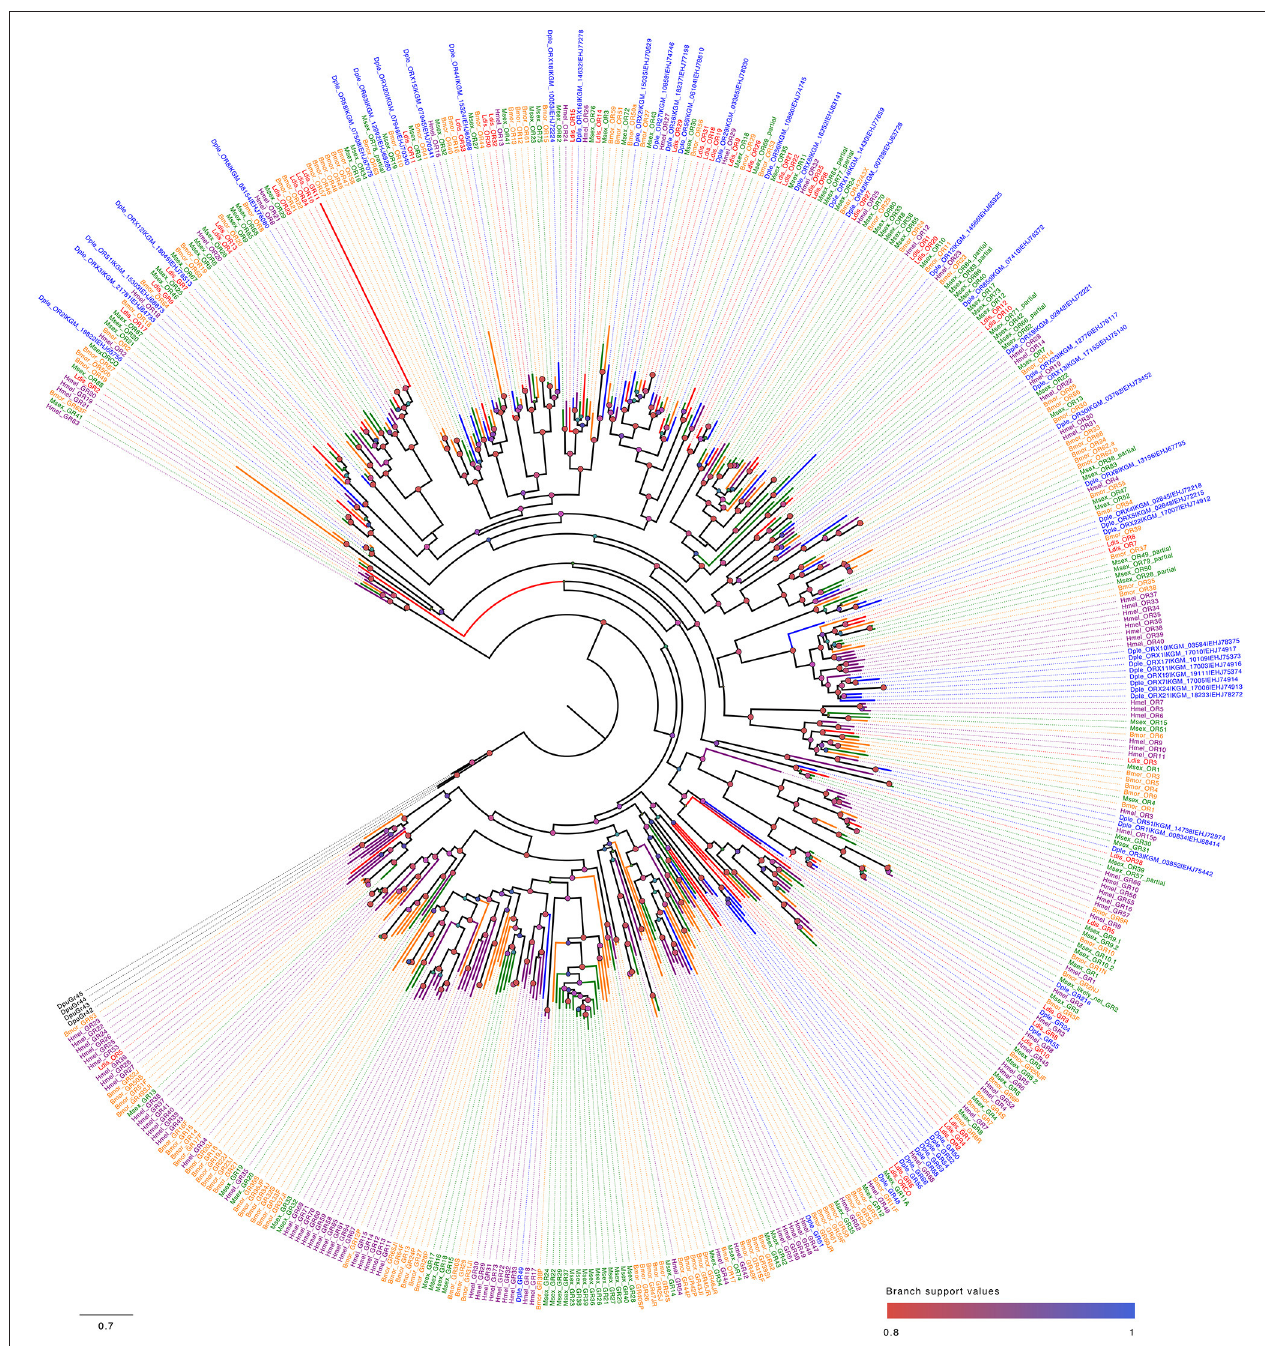
FIGURE 5 | Maximum likelihood dendrogram based on protein sequences of candidate gustatory receptors ( GRs ) and odorant receptors ( ORs ). Included are the putative sequences for Lymantria dispar (Ldis) plus those available for model Lepidoptera species Bombyx mori (Bmor), Danaus plexippus (Dple), Heliconius melpomene (Hmel), and Manduca sexta (Msex), we also included sequences from the waterflea Daphnia pulex (Dpu) as an